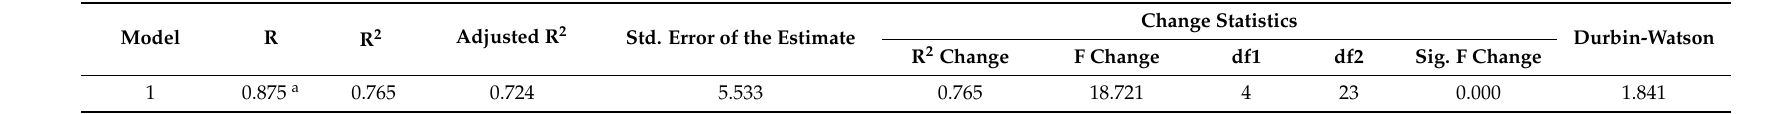
Table 17. Model Summary for Thessaloniki b .